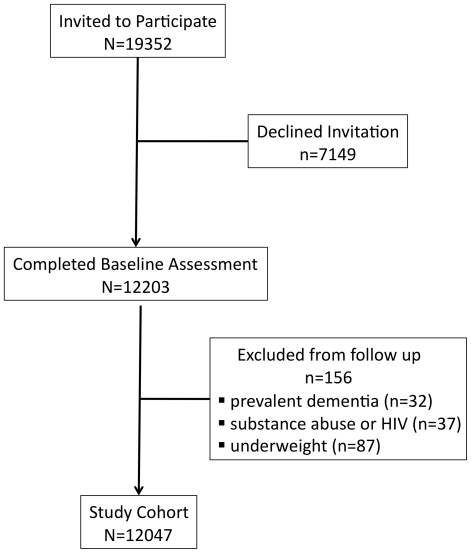
Flow of participants from invitation to inclusion in the study.